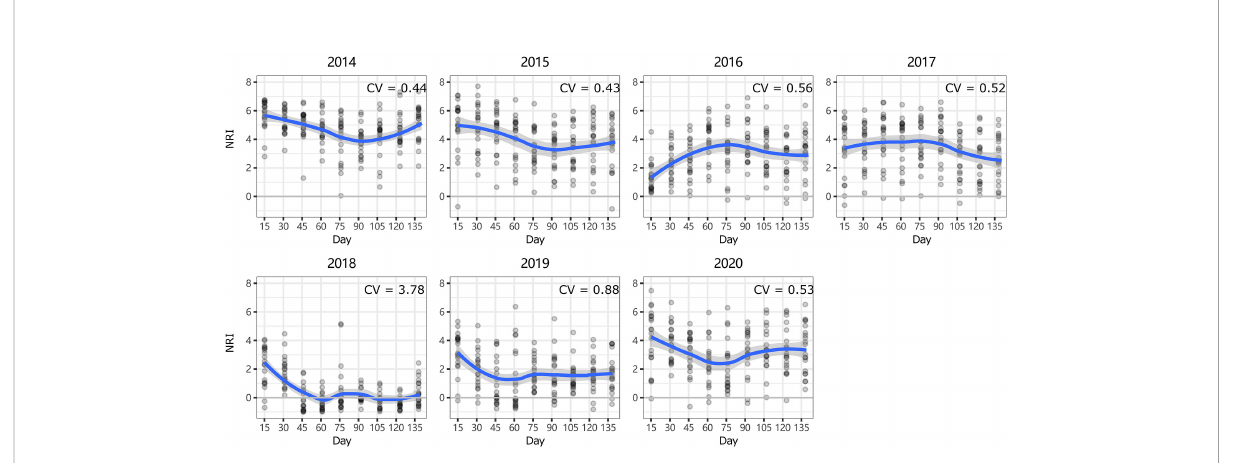
FIGURE 4 Intra-annual dynamics of community phylogenetic structure at the Inner Mongolia Grassland Ecosystem Research Station (ERS) in Inner Mongolia, China. The ordinate shows the net relatedness index (NRI). The abscissa shows the number of days since May 1. The blue line indicates the model prediction. The gray area shows the 95% con fi dence interval around the mean.